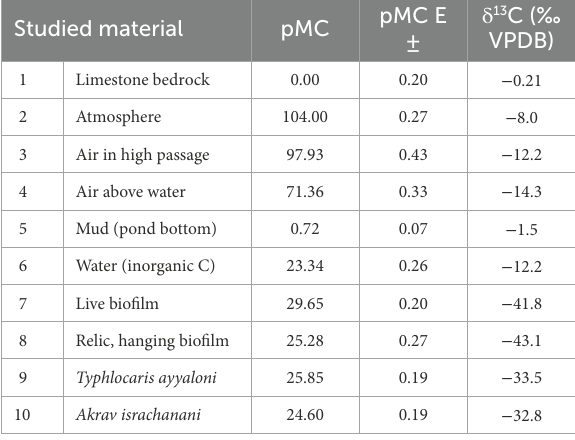
TABLE 3 Carbon isotopes in organic matter of Ayyalon Cave and in possible sources of